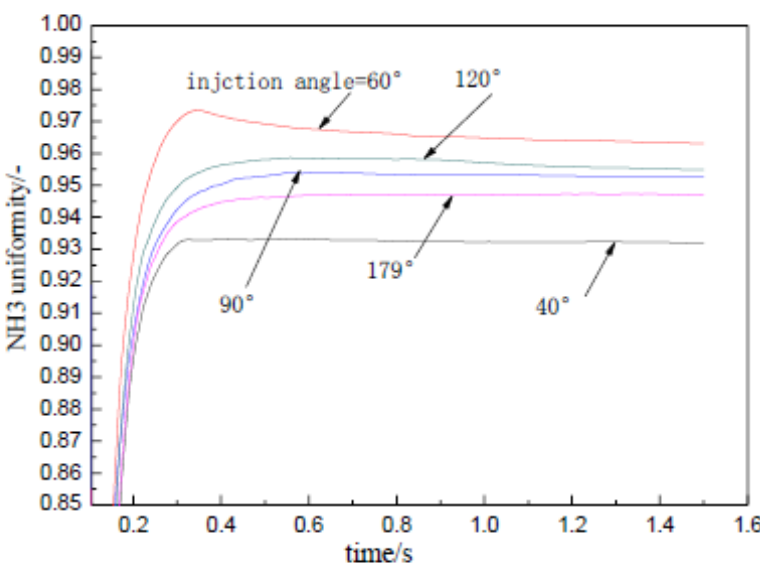
Fig. 9 Distribution uniformity of NH 3 in the inlet section of catalytic carrier.